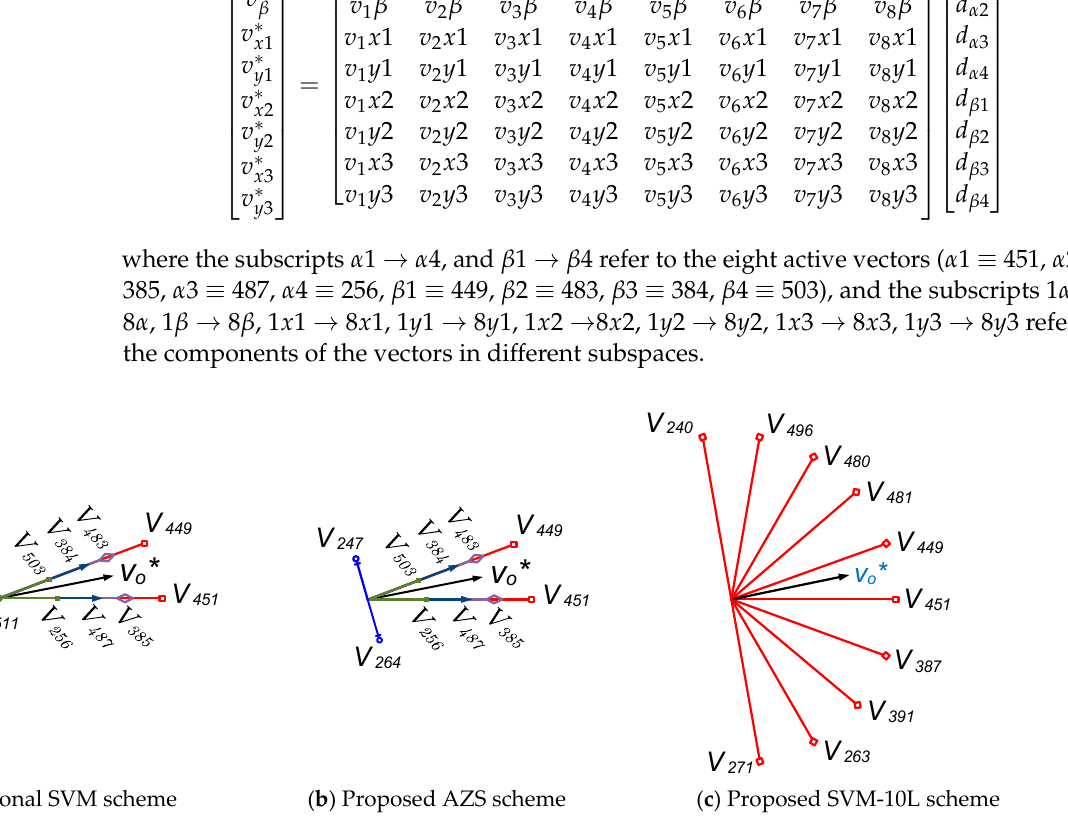
Figure 3. Selected space-vectors of sector 1 in α − β subspace corresponding to the traditional and proposed SVM technique. Note that, the asterisks (*) denote the reference.